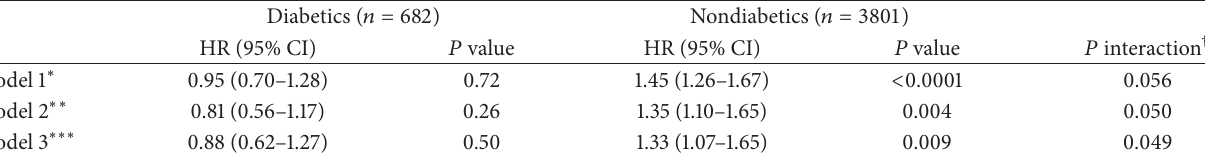
Table 4: Hazard ratio (95% CI) of SCD per each SD (18.98ng/mL) increase of FABP4 concentration, by diabetes status ( 𝑛 = 4483